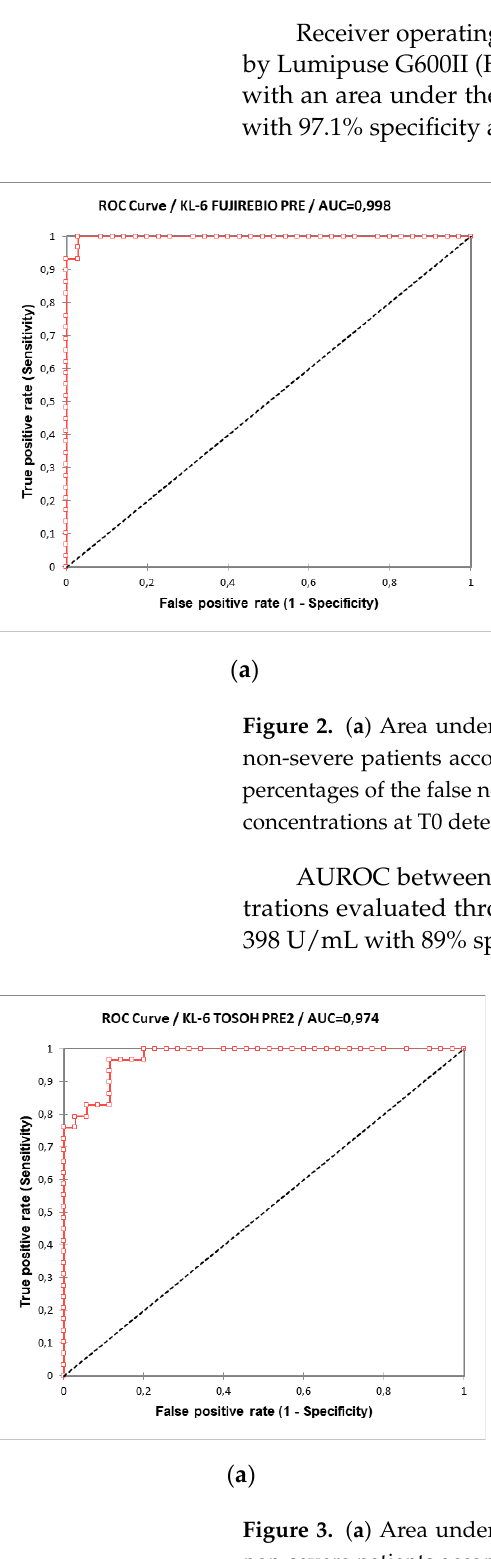
( b ) Figure 4. ( a ) the linearity of L1 and L2 reagent concentrations by Fujirebio analysed on AIA360 in- strument. ( b ) Bland–Altman analysis for L1 and L2 concentrations for assessing agreement and Bias between systems. The QQ plot (Figure S1) was obtained using four degrees of freedom (Lumipulse KL- 6 T0 and KL-6 T1, AIA360 KL-6 T0 and KL-6 T1) with the coefficient of determination (R2) of the regression analysis of 0.5977. D ay 1 D a y 2 D a y 3 D a y 4 D a y 5 D a y 6 D a y 7 D a y 8 D a y 9 D ay 1 0 D ay 1 1 D ay 1 2 D ay 1 3 D ay 1 4 D ay 1 5 D ay 1 6 D ay 1 7 D ay 1 8 D ay 1 9 D ay 2 0 D ay 2 1 150 160 170180 190